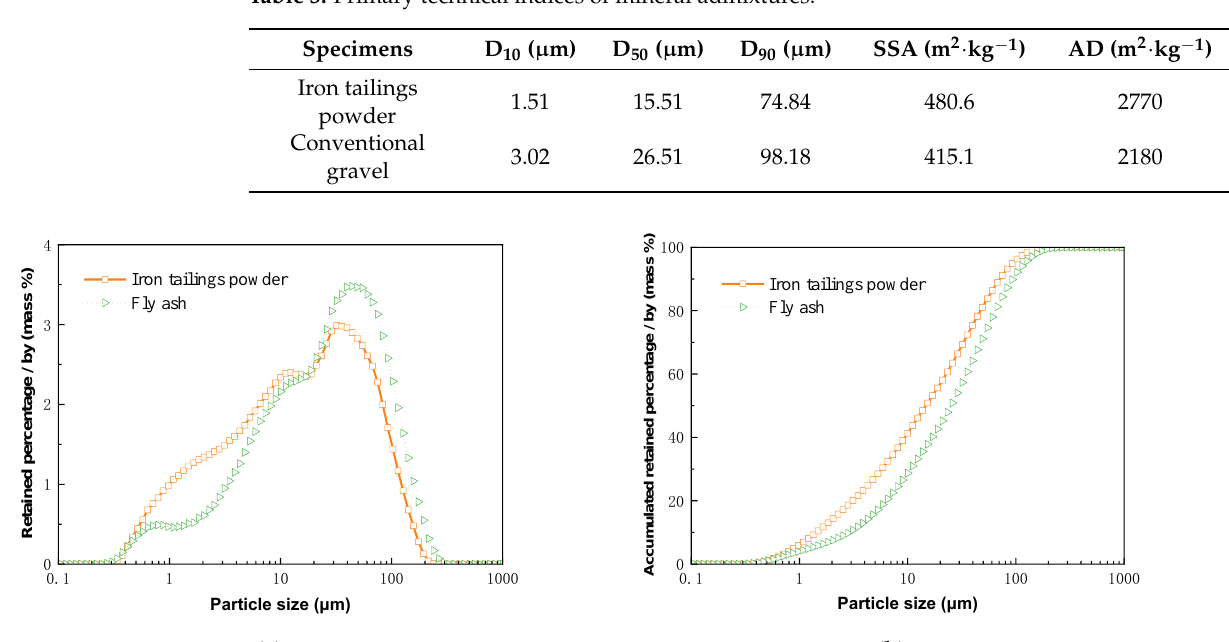
Table 3. Primary technical indices of mineral admixtures. Figure 5. Particle size distribution curves of two mineral admixtures. Figure 5. Particle size distribution curves of two mineral admixtures: ( a ) particle size distribution; ( b ) cumulative particle size Table 2. Primary technical indices of Portland cement.